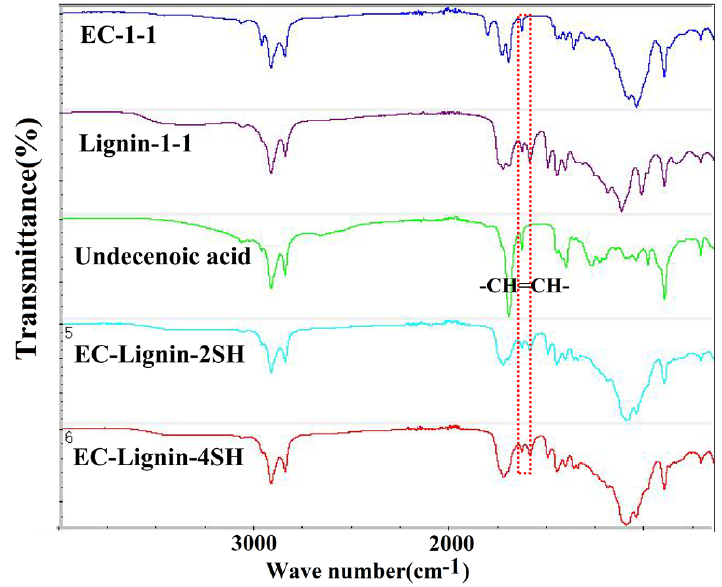
Figure 11. FT − IR of the EC–lignin cross − linked polymers compared with that of lignin − 1 − 1, EC − 1 − 1 and undecenoic acid.